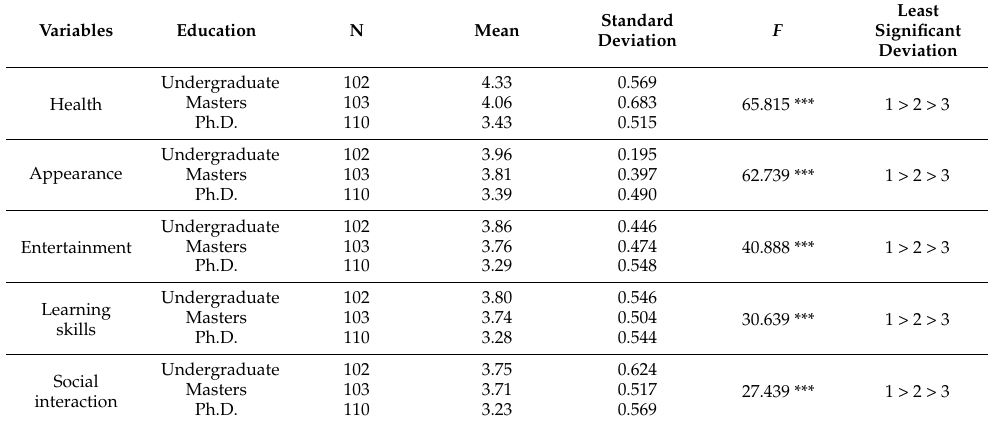
Table 4. Differences in foreign students’ physical exercise motivation based on academic